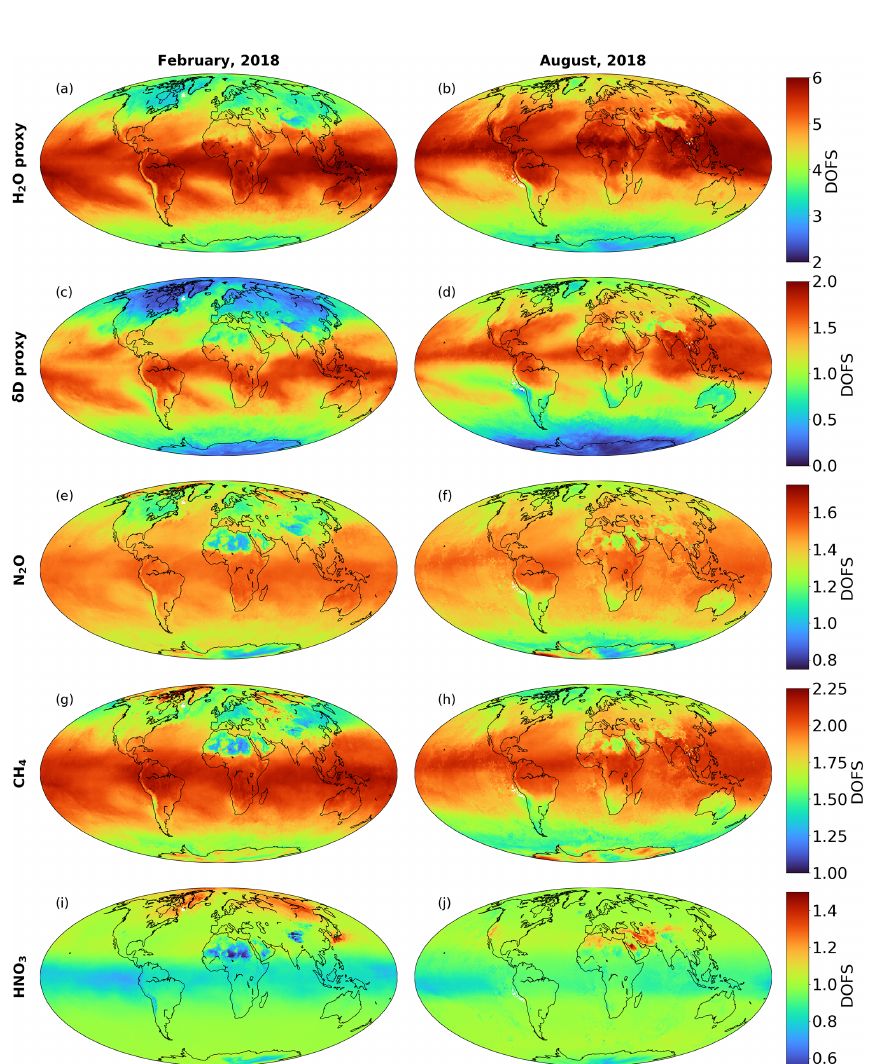
Figure 10. Monthly averaged maps of degree of freedom for signal (DOFS) values for February and August 2018 for all targeted atmospheric species: H 2 O, δ D, N 2 O, CH 4 , and HNO 3